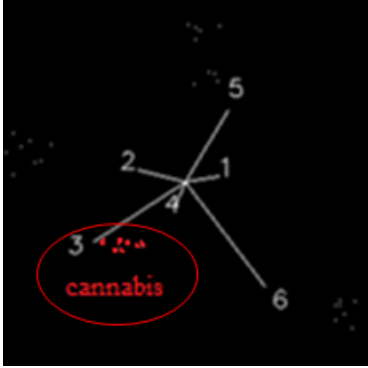
Figure 4. Pure Cannabis pixels’